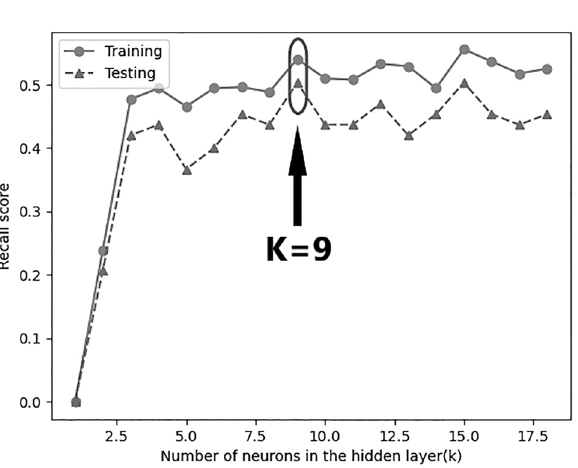
Figure 1. Texture feature selection using the least absolute shrinkage and selection operator (LASSO) binary logistic regression model. ( A ) LASSO coefficient profiles of the 19 texture features. ( B ) Tuning parameter (λ) selection in the LASSO model used ten-fold cross validation via minimum criteria.